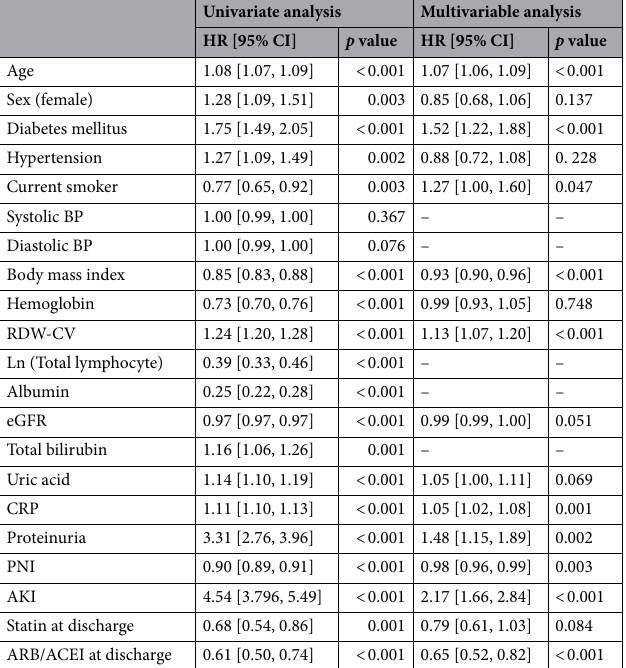
Table 3. Prognostic factors related to patients’ mortality. HR hazard ratio, CI confidence interval, BP blood pressure, RDW-CV red cell distribution width coefficient of variation, eGFR estimated glomerular filtration rate, CRP C-reactive protein, PNI prognostic nutritional index, AKI acute kidney injury, ARB angiotensin II receptor blocker, ACEI angiotensin converting enzyme inhibitor.